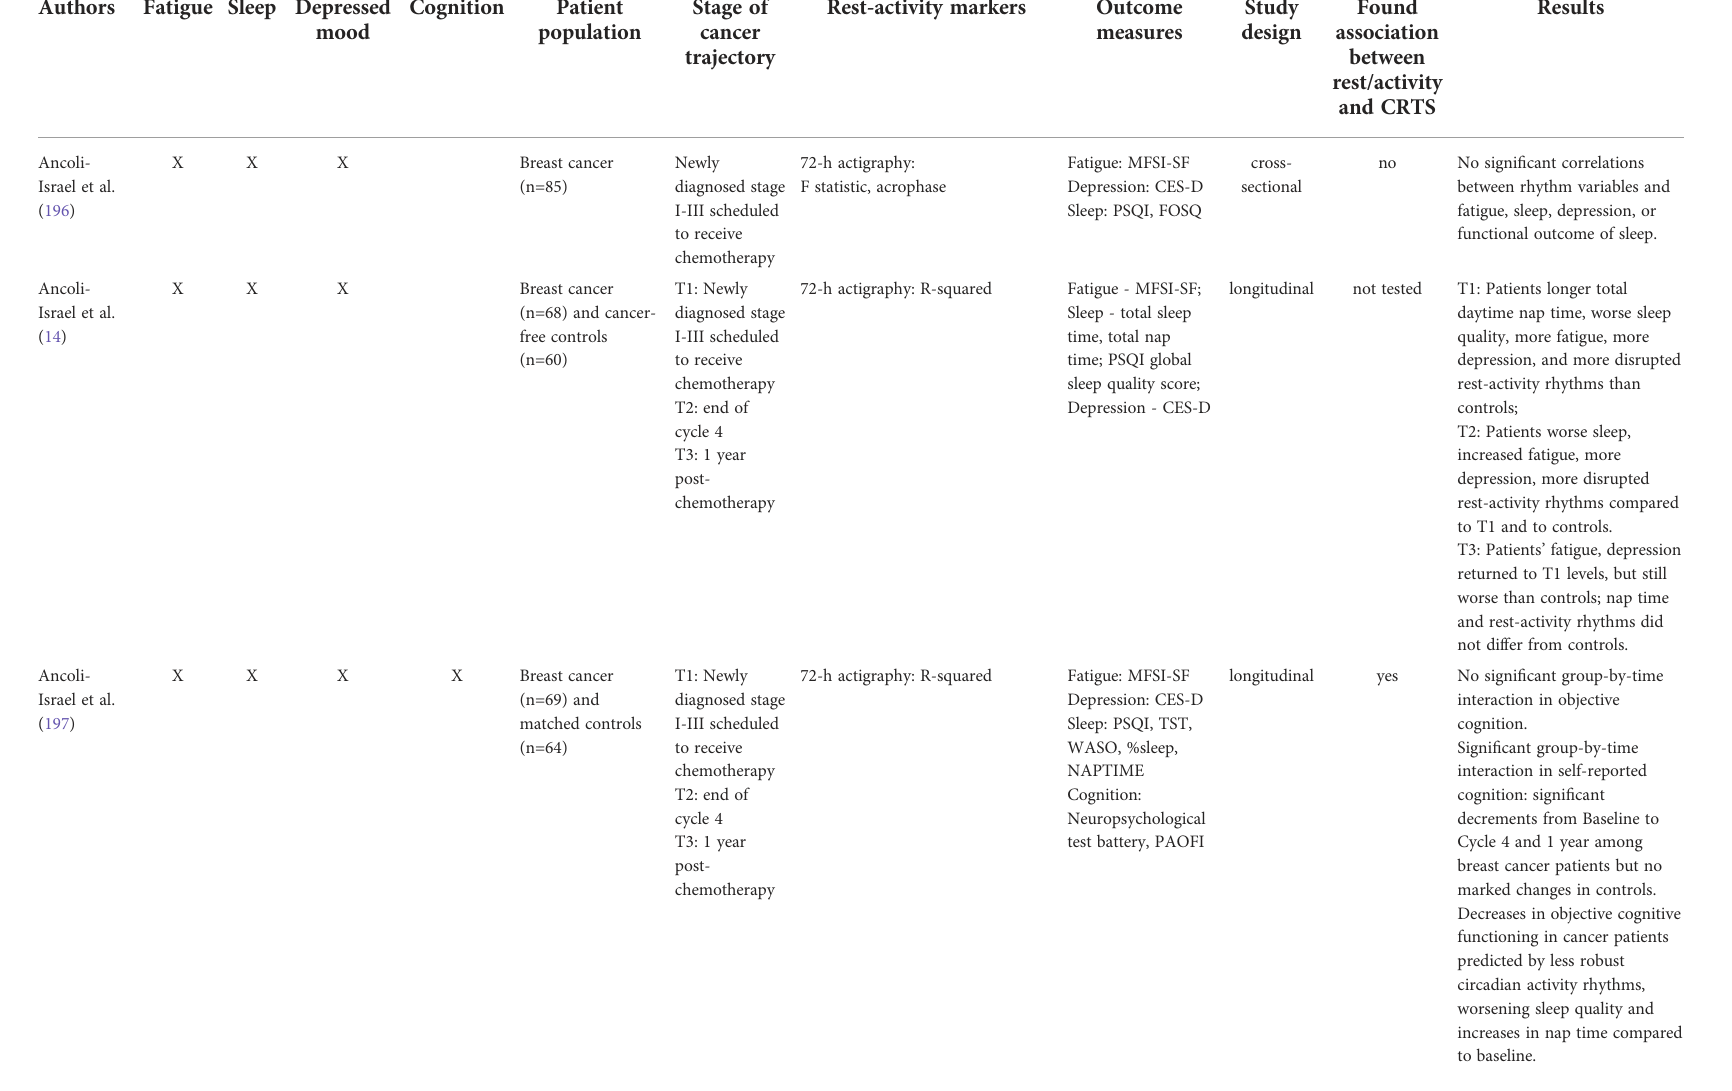
TABLE 3 Summary of studies that examined rest-activity and cancer- and treatment-related